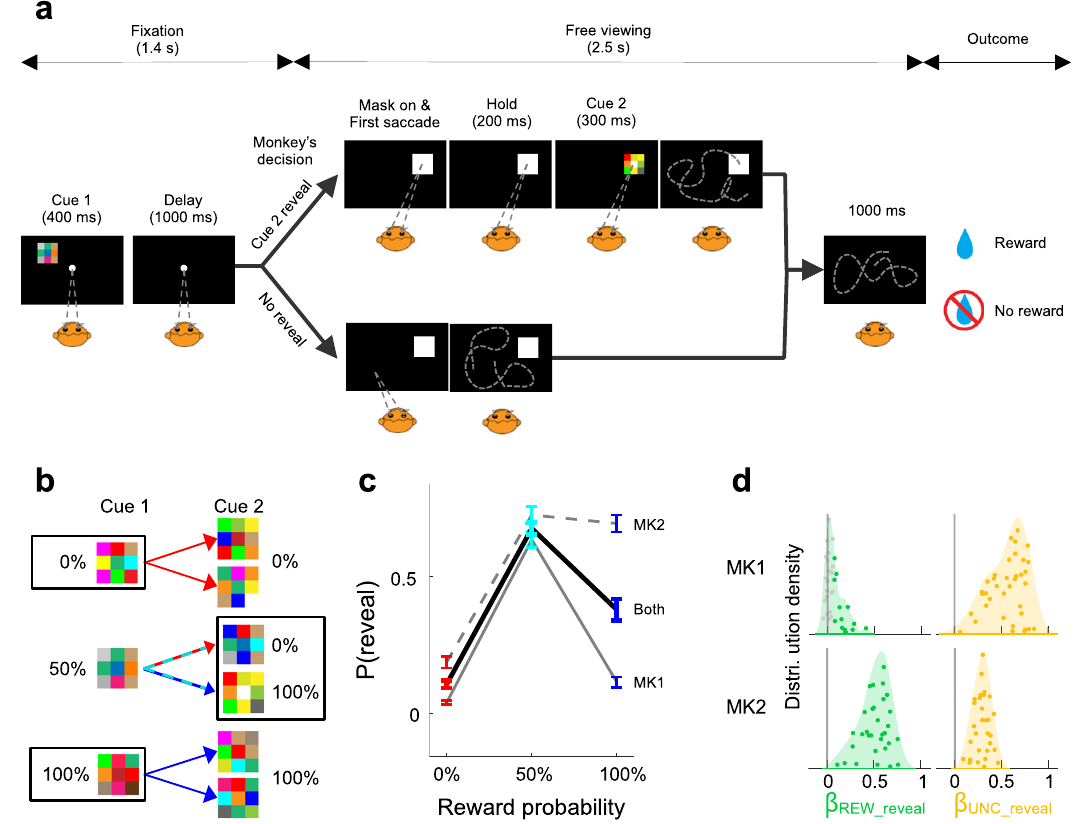
Fig. 1 | Task and behavior. a Trial structure in the information-seeking task. The